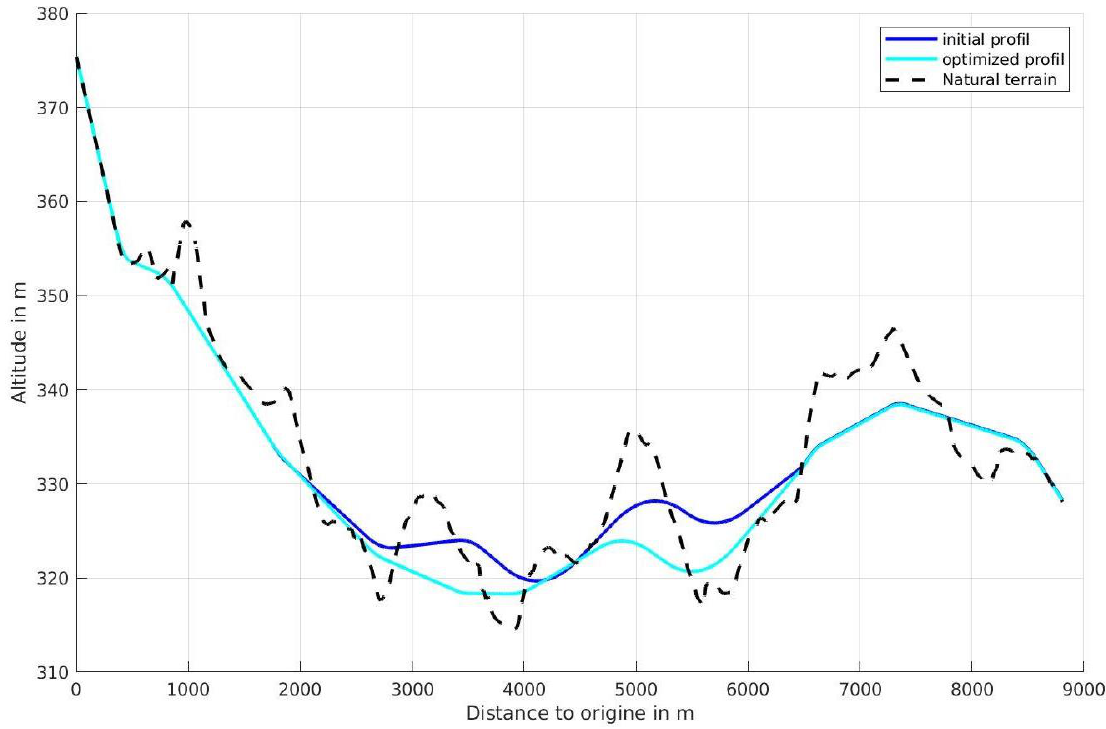
Figure 4. Optimized